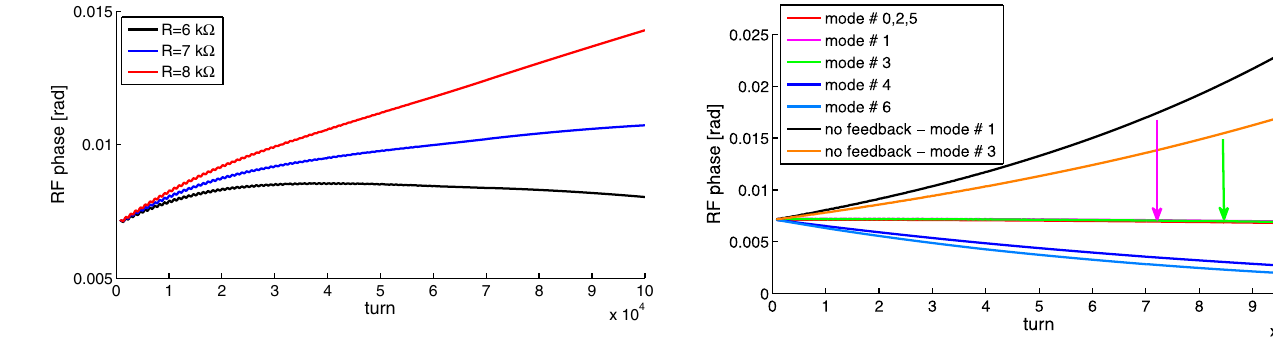
FIG. 7. Amplitude of the multibunch oscillation modes as a function of the number of turns given by M U S I C in the presence of the feedback system and compared with the simulation without feedback of the left side of Fig. 3. The bunches have a Gaussian distribution with rms length equal to 0.07